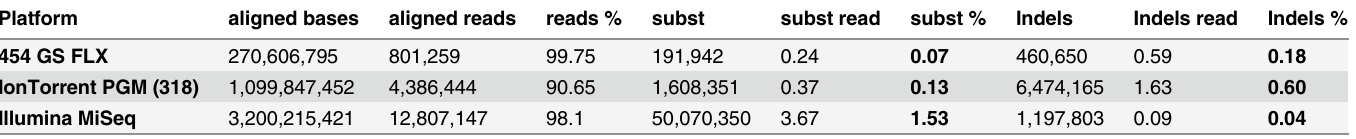
Table 2. Platform comparison — error rates. Platform aligned